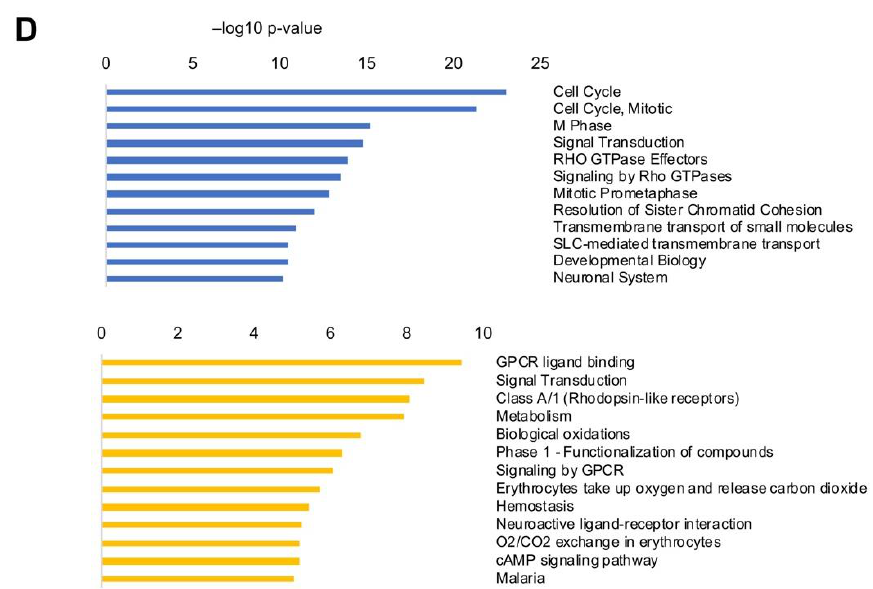
Figure 4. Gene expression analysis of LUAD TCGA tumors. ( A ) Up- and down-regulated genes in LUAD versus normal lung tissues. NS, not significant. ( B ) Pscan analysis of enriched TFBS in promoters (−450/+50 bps from the TSS) of up- and down-regulated genes in LUAD. ( C ) Weeder analysis of enriched de novo matrices in promoters of upregulated genes. ( D ) Reactome pathways enriched in upregulated genes (upper panel) and down-regulated genes (lower panel) listed according to their p -value. The list was obtained using KOBAS.